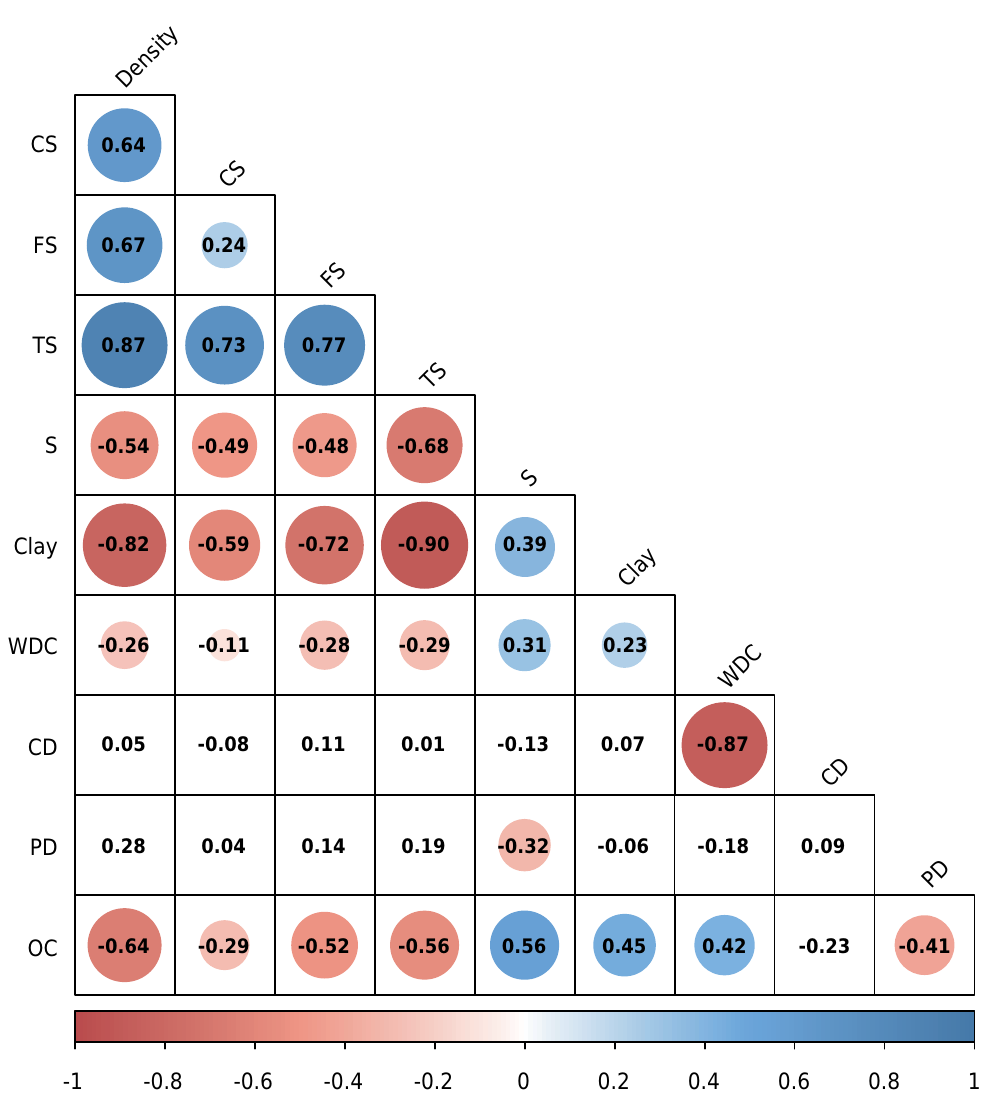
Figure 3. Correlogram between density and the nine possible predictive variables for the development of pedotransfer functions. Density: density of fine earth; CS: coarse sand; FS: fine sand; TS: total sand; S: silt; WDC: water dispersed clay; CD: clay dispersion (%); PD: particle density; and OC: organic